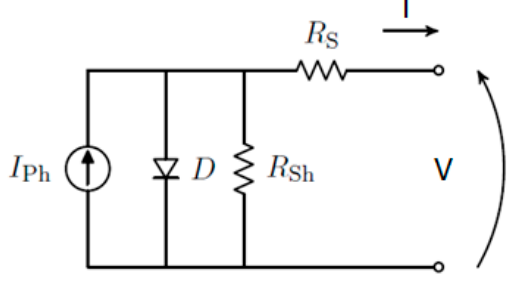
Figure 1. Five ‐ parameters model of a photo ‐ voltaic (PV) cell. Figure 1. Five-parameters model of a photo-voltaic (PV)